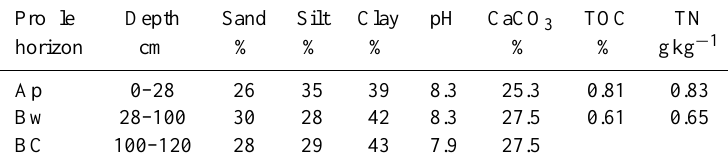
Table 1. Main soil properties of the experimental area under ordinary vineyard management and grape production. Profile Depth Sand Silt Clay pH CaCO 3 TOC TN horizon cm